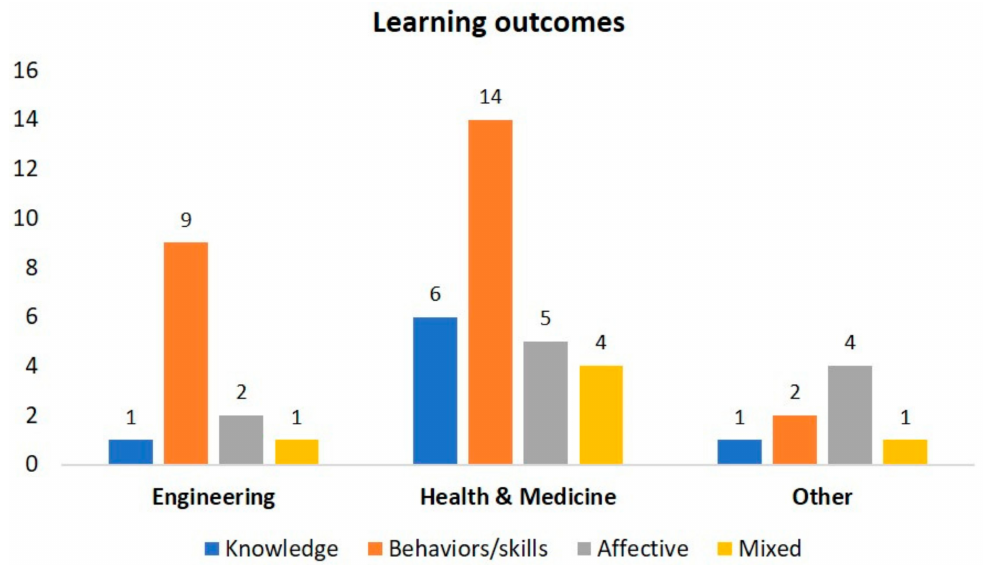
Figure 7. Learning outcomes in AR-supported instruction in three